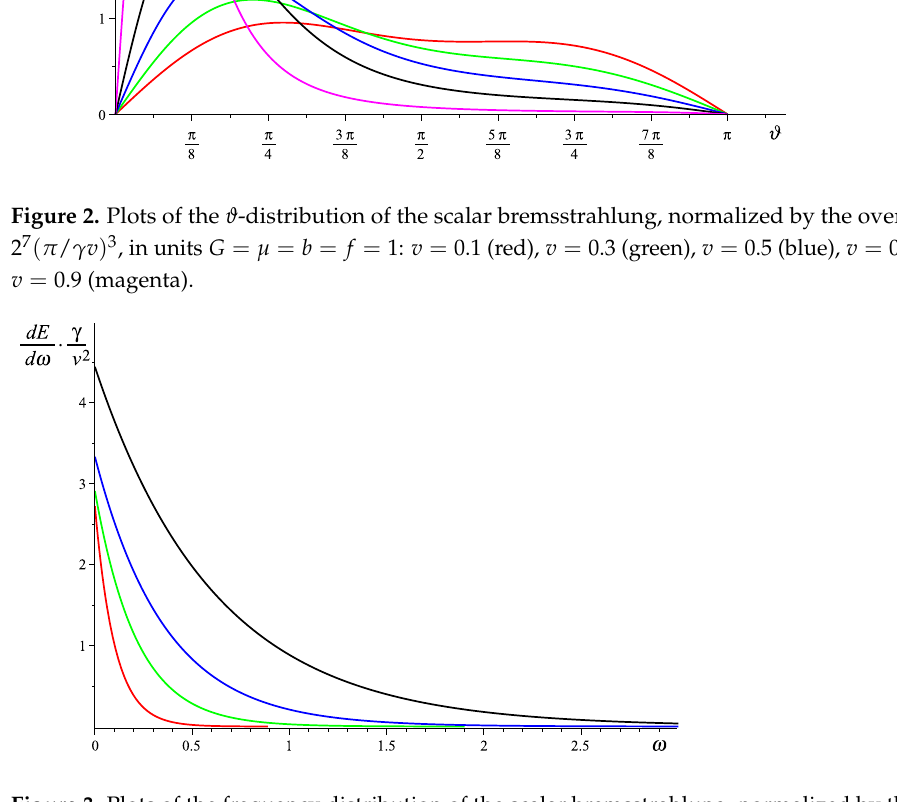
Figure 3. Plots of the frequency distribution of the scalar bremsstrahlung, normalized by the overall factor γ / v 2 , in units G = µ = b = f = 1: v = 0.2 (red), v = 0.4 (green), v = 0.6 (blue), v = 0.8